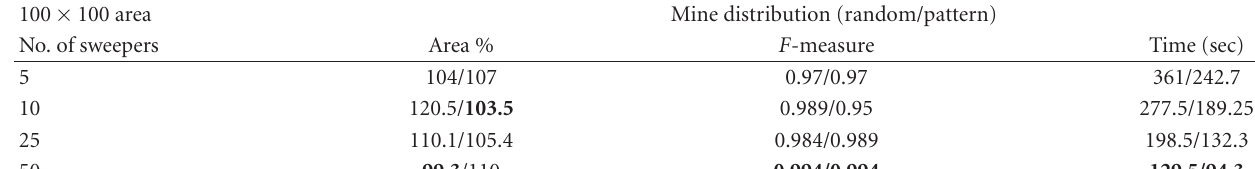
Table 3: Mine distribution model.